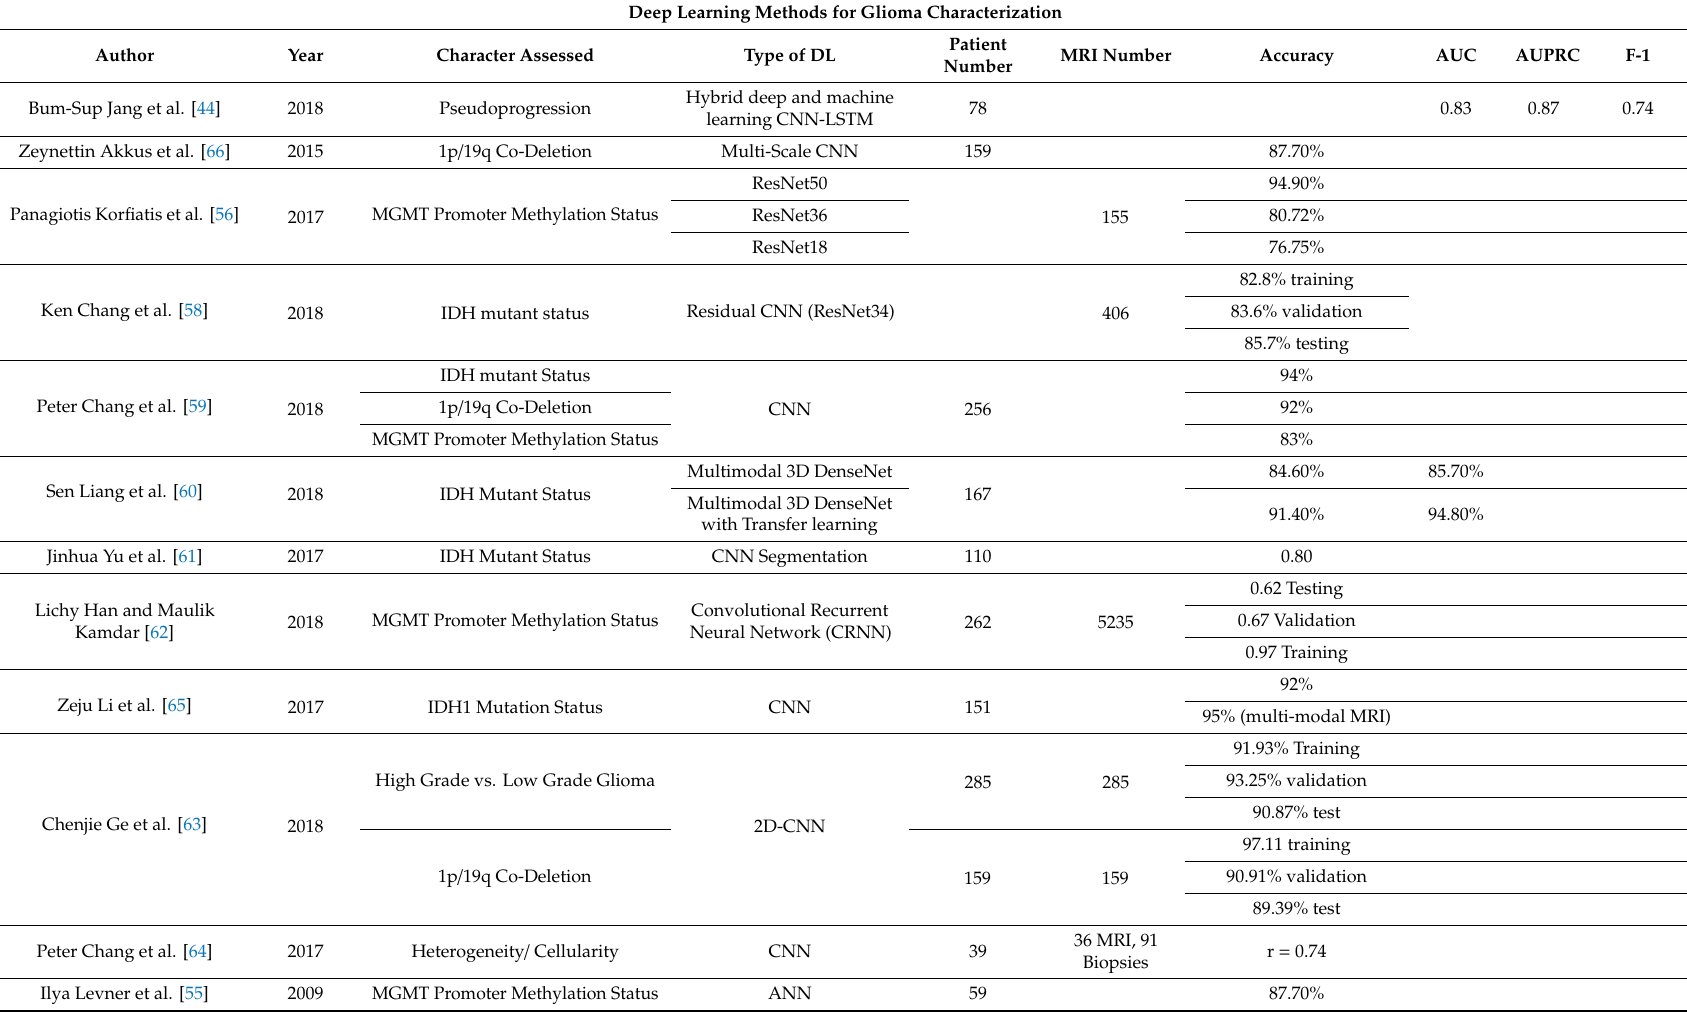
Table 2. A summary of deep learning methods in the characterization of gliomas on MR